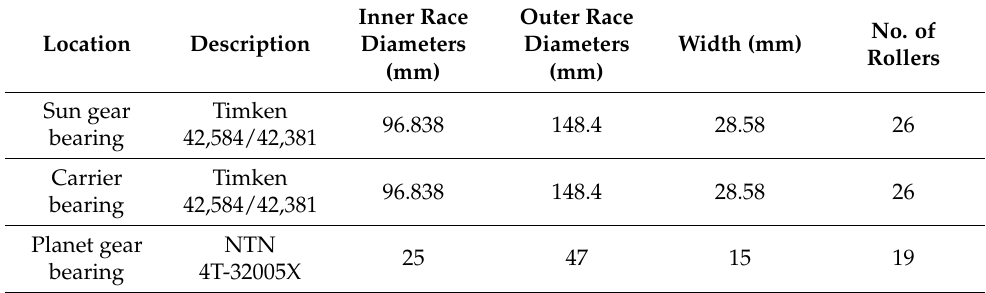
Table 2. Parameters of two carrier bearings and planet gear bearings for the two-stage planetary gearboxes.